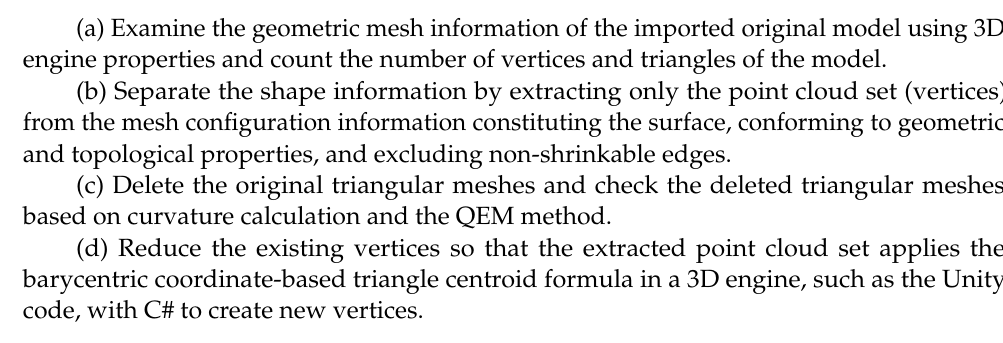
Figure 3. Flowchart of mesh reconstruction algorithm.